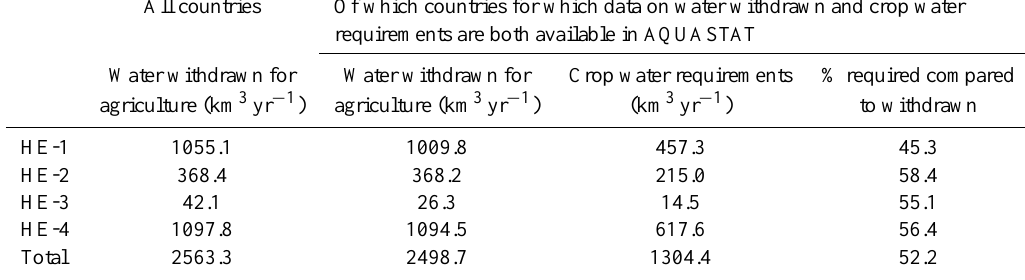
Table A11. Water withdrawn for agriculture and water required for irrigation around the year 2000. All countries Of which countries for which data on water withdrawn and crop water requirements are both available in AQUASTAT Water withdrawn for Water withdrawn for Crop water requirements % required compared